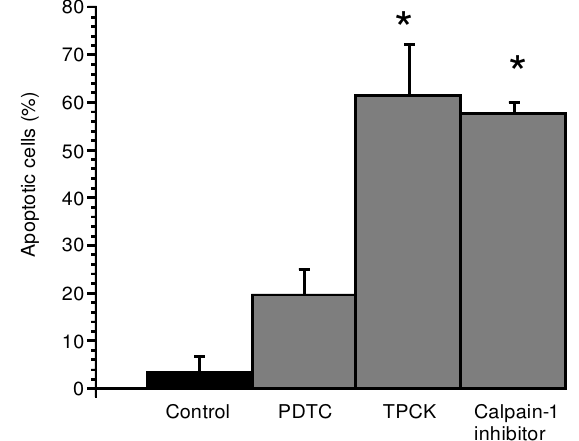
FIG. 2. Effects of NF- k B inhibitors on apoptosis measured by TUNEL/¯ ow cytometry. RAW 264.7 cells were incubated for 18 h with either no treatment, 100 m M PDTC, 50 m M TPCK, or 10 m M calpain I inhibitor. The percentage of cells undergoing apoptosis was quanti® ed by ¯ ow cytometry using TUNEL staining and is depicted on the ordinate. , signi® cant increases in apoptosis compared to controls (P , 0 · 05). Error bars represents SEM. Each experiment was repeated at least three